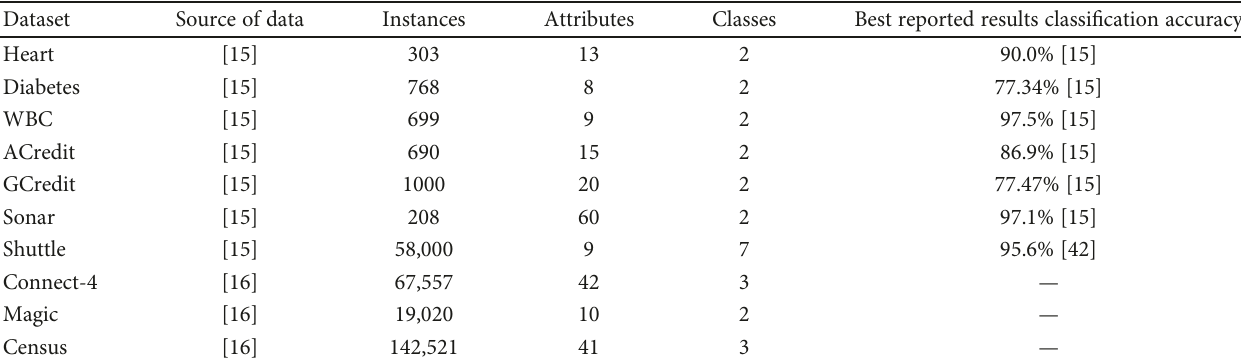
Table 1: Characteristics of the datasets used in this